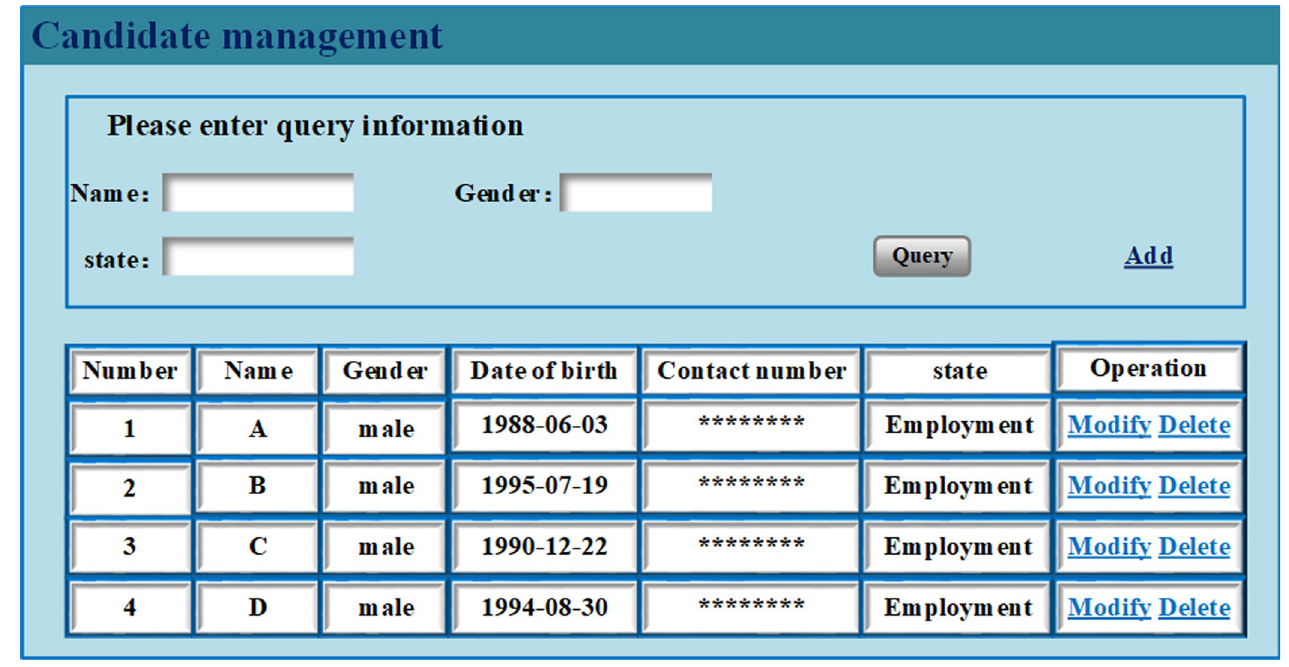
Fig 14. The interface of the recruitment